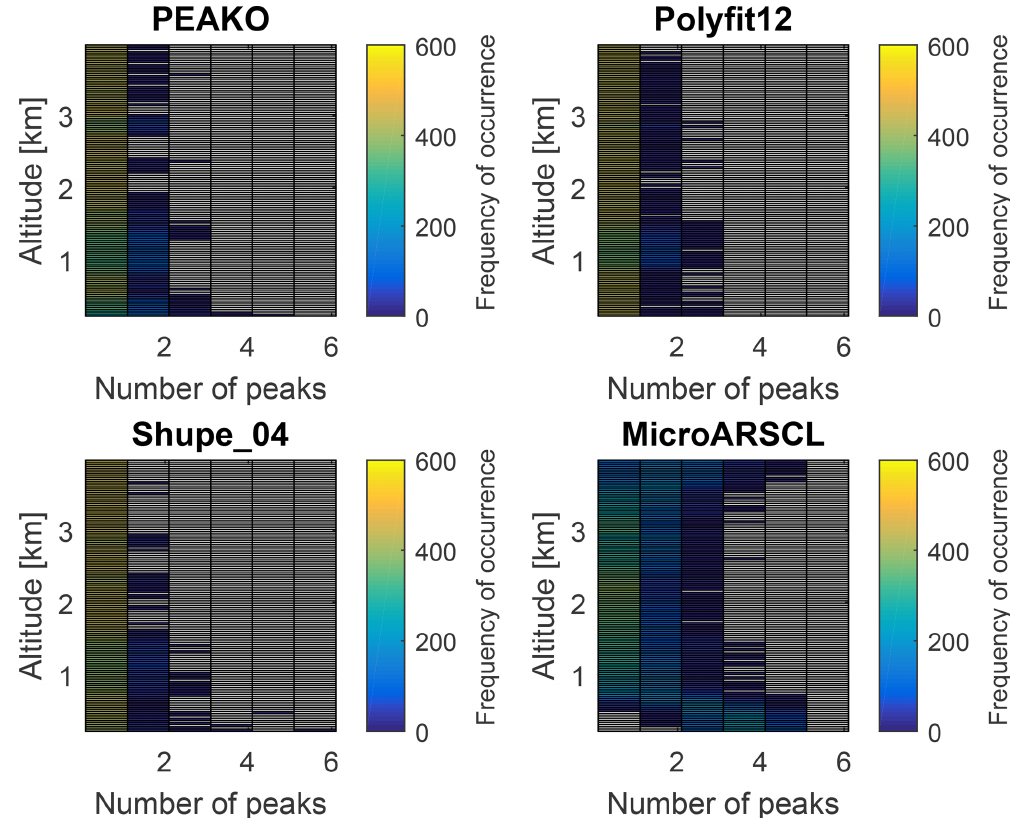
Figure B3. Like Fig. 6 but for the case study period on 21 February 2014, 23.01–23.25UTC, at 0.2–4km